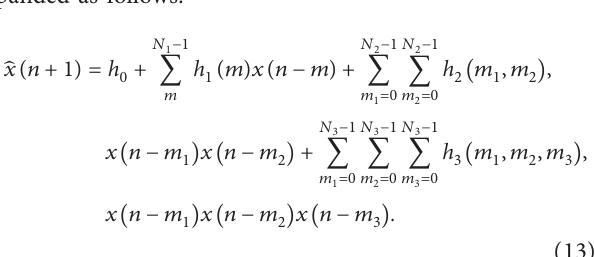
Figure 2: Process of symbolization and coding (data and symbolics in virtual frame will not be symbolized or encoded). In creation of code series, symbolic length m is 3. The first and last elements will not be transformed according to the determination of symboli- zation, and the last n − 1 bit symbolics are not encoded for this encoding process.